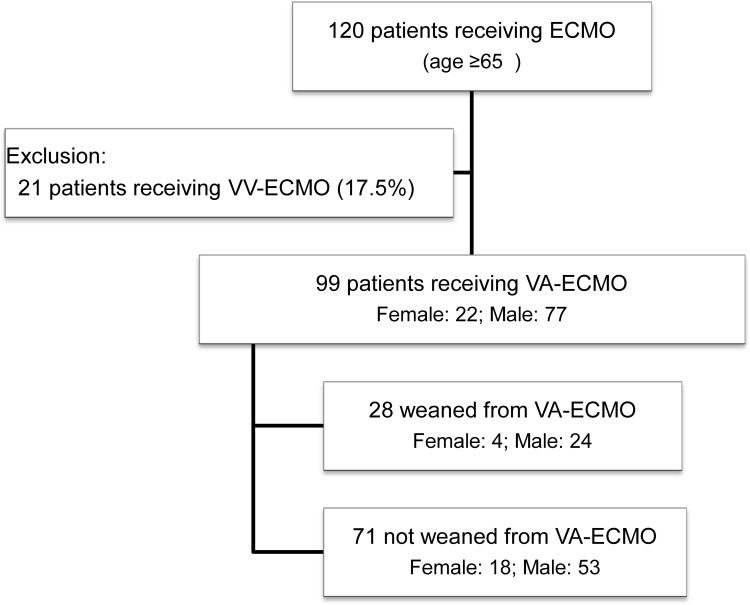
Flow chart of patients received ECMO from 2009–2012.